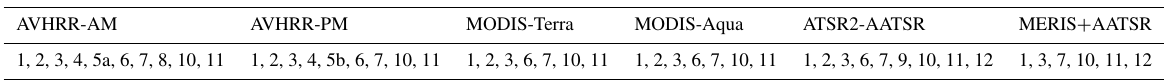
Table B1. Mapping the listed limitations above to the Cloud_cci datasets they apply